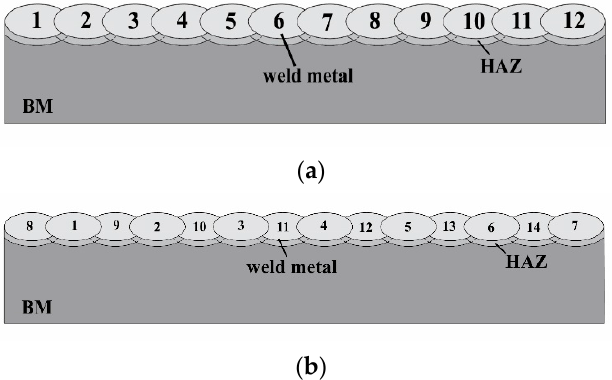
Figure 1. The schematic view of the specimens with the order of laid beads ( a ) welded in the air and ( b ) welded underwater.